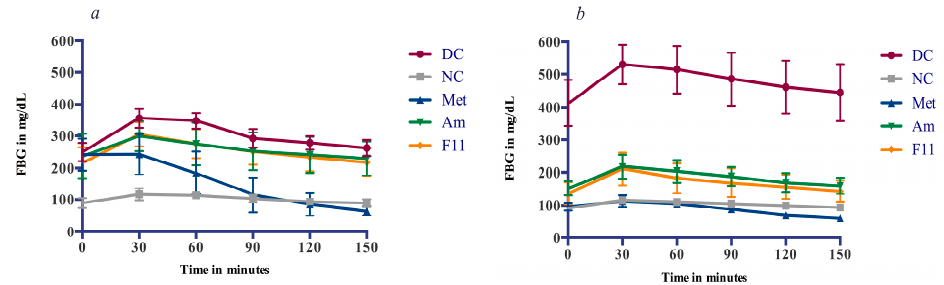
Table 2. Changes in fasting blood glucose and metabolic